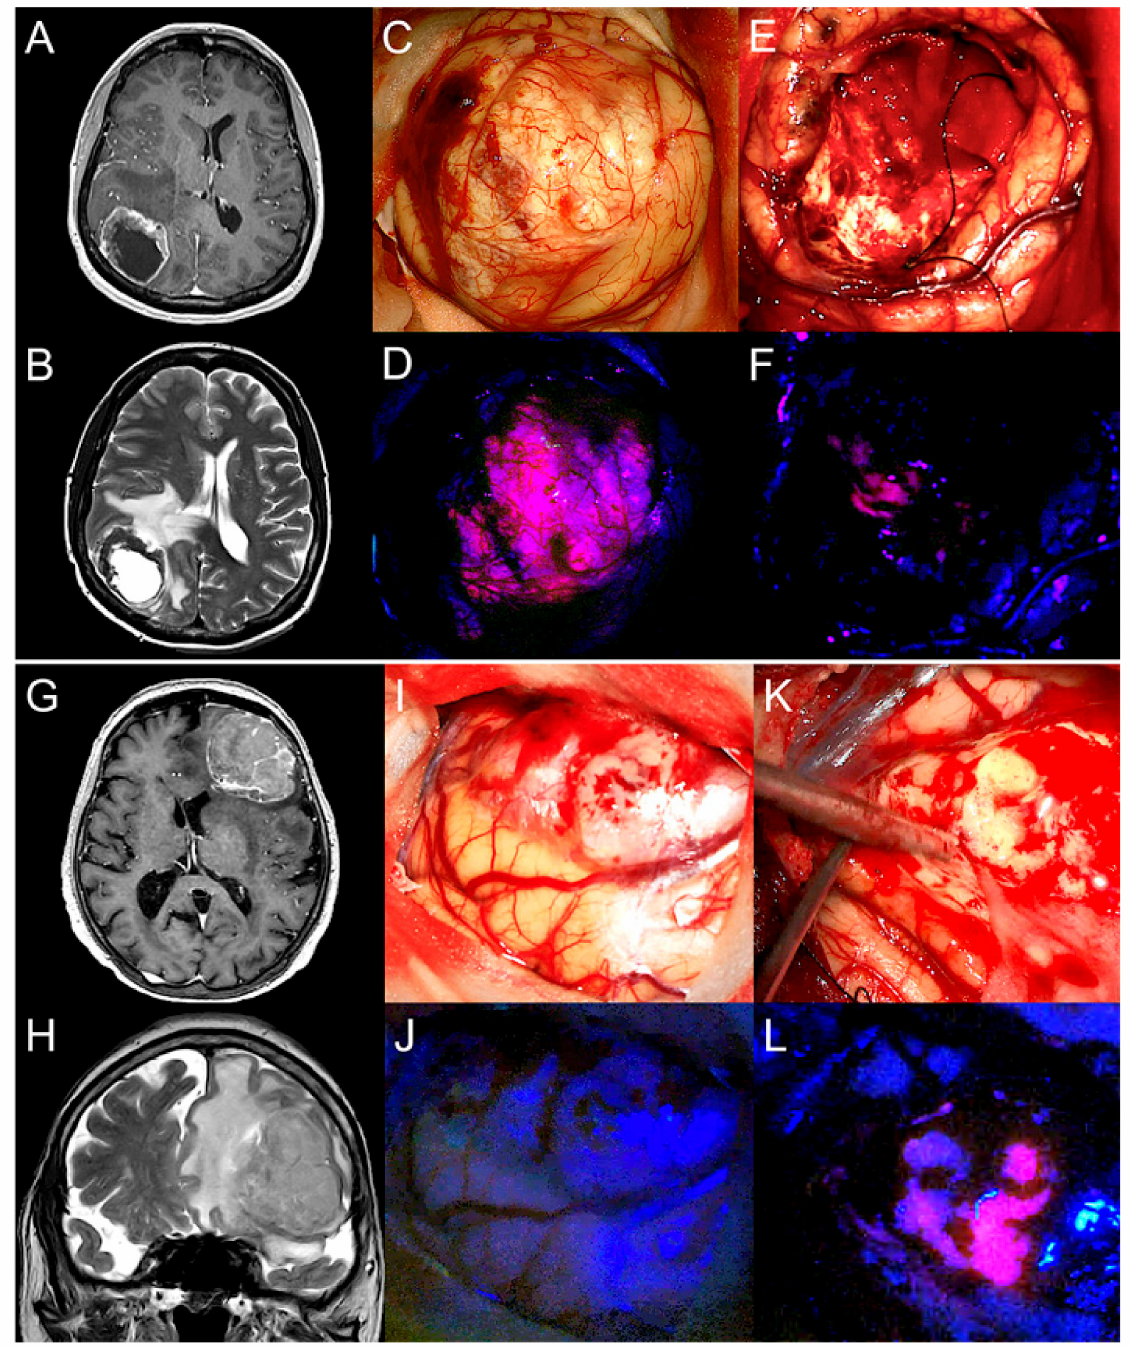
Figure 2. Characteristic fluorescence patterns of the tumor and peritumoral brain tissue in two patients with surgery of a brain metastasis after preoperative 5-ALA administration. ( A ) The brain metastasis of the first patient in the right occipital lobe demonstrates a cystic pattern of contrast-enhancement on T1-weighted MR images and ( B ) shows a distinct peritumoral edema on T2-weighted images. ( C ) After dura opening, the tumor is visible under conventional white-light microscopy and ( D ) demonstrates strong 5-ALA fluorescence under violet-blue excitation light. ( E ) Although the brain metastasis was completely removed under white-light microscopy, ( F ) visible fluorescence is detected in the peritumoral brain tissue. ( G ) The brain metastasis of the second patient in the left frontal lobe is characterized by heterogenous contrast-enhancement on T1-weighted images ( H ) with an extensive peritumoral edema. ( I ) During surgery, the brain metastasis is visible under conventional white-light microscopy, ( J ) but no visible fluorescence is detected under violet-blue excitation light. ( K ) After complete removal of the brain metastasis under white-light microscopy, ( L ) visible fluorescence is found in the peritumoral brain tissue although the brain metastasis itself did not reveal any visible